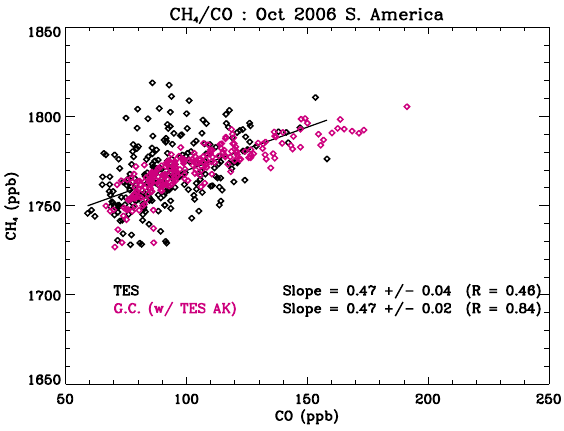
Fig. 10. Distribution of CH 4 and CO over South American fires. The TES data are shown in black. The GEOS-Chem data (adjusted with the TES operator) are in red. A linear fit to the TES data is shown as a black line.